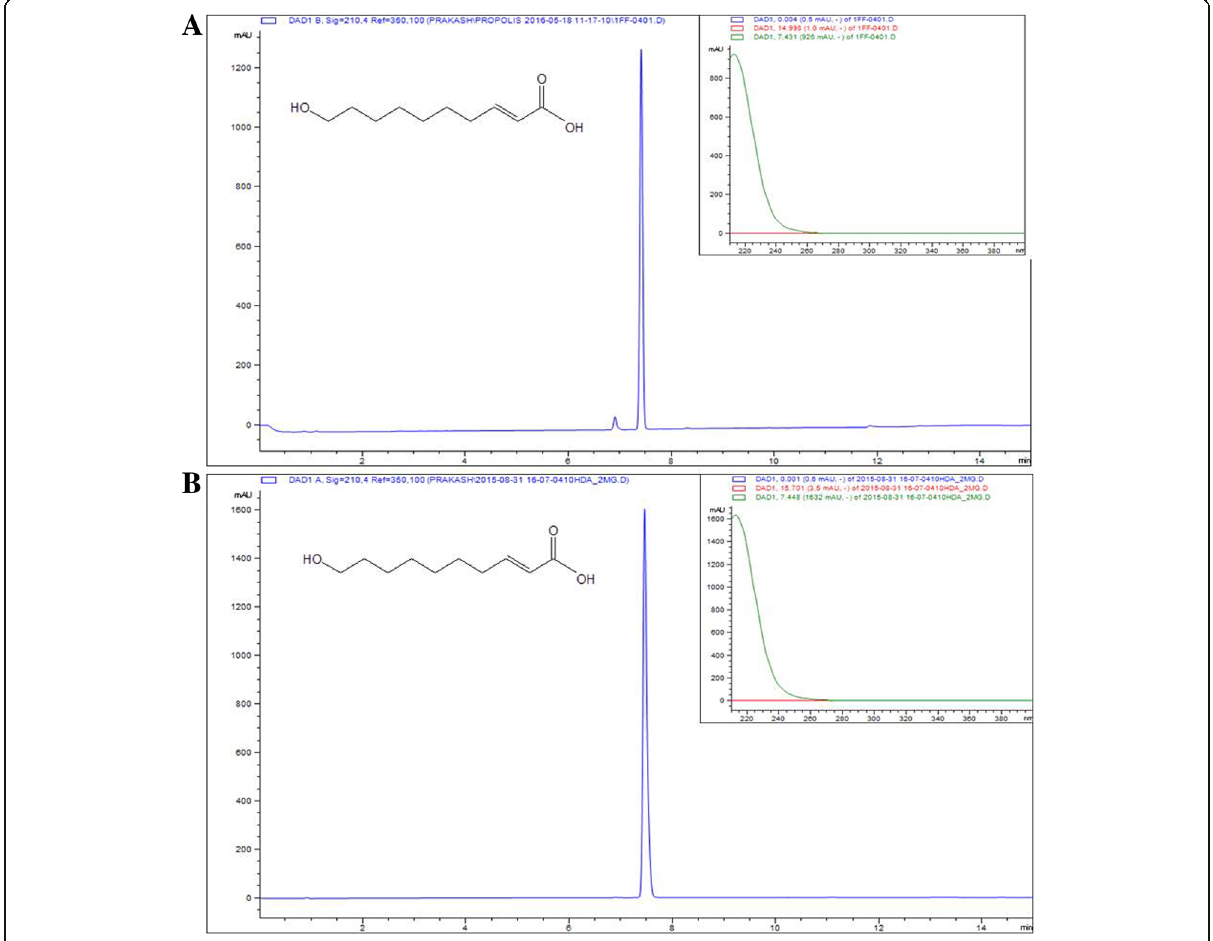
Fig. 1 UPLC chromatogram of ( a ) isolated and ( b ) standard 10-Hydroxy-2-decenoic acid (10-HDA) with